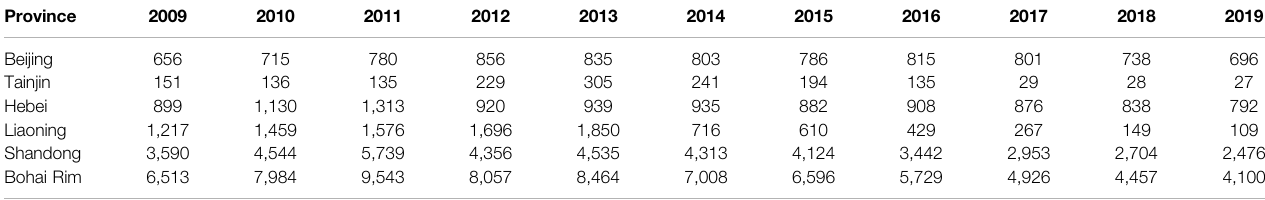
TABLE 2 | Carbon emission of high-end equipment manufacturing in the Bohai Rim (10 kilo-tons). Province